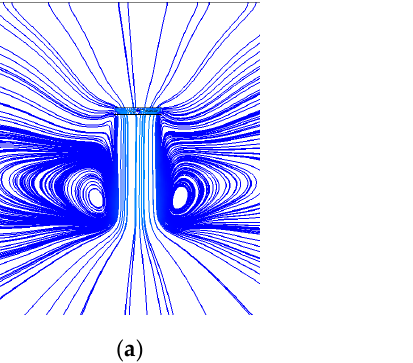
Figure 12. Downwash of the rotor. ( a ) Streamline; ( b ) velocity.